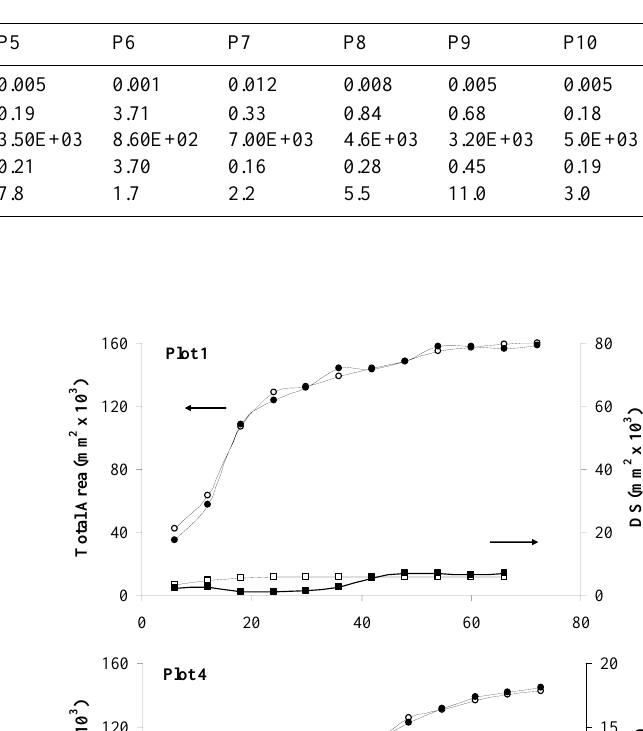
Table 3. Froude ( F ), Reynolds ( Re ) numbers and C , d ∗ parameter values and slopes ( s , %) of the field plot experiments.